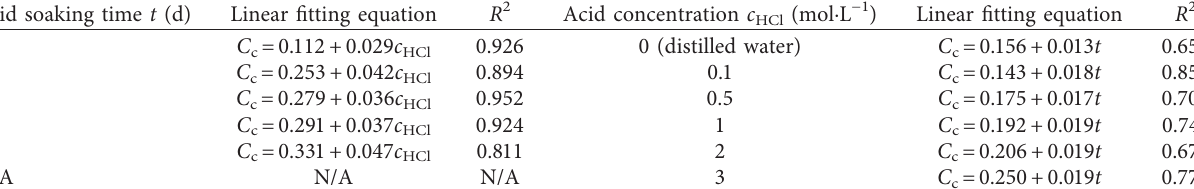
c , soaking time, and acid concentration.